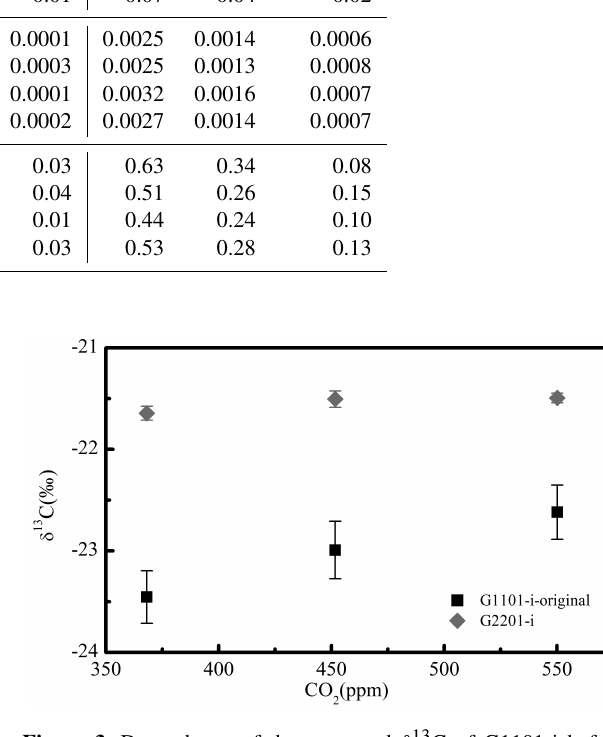
Figure 3. Dependency of the measured δ 13 C of G1101-i before upgradation (G1101-i-original) and G2201-i analyzers on the mea- sured CO 2 concentration with three different CO 2 concentrations with same δ 13 C reference